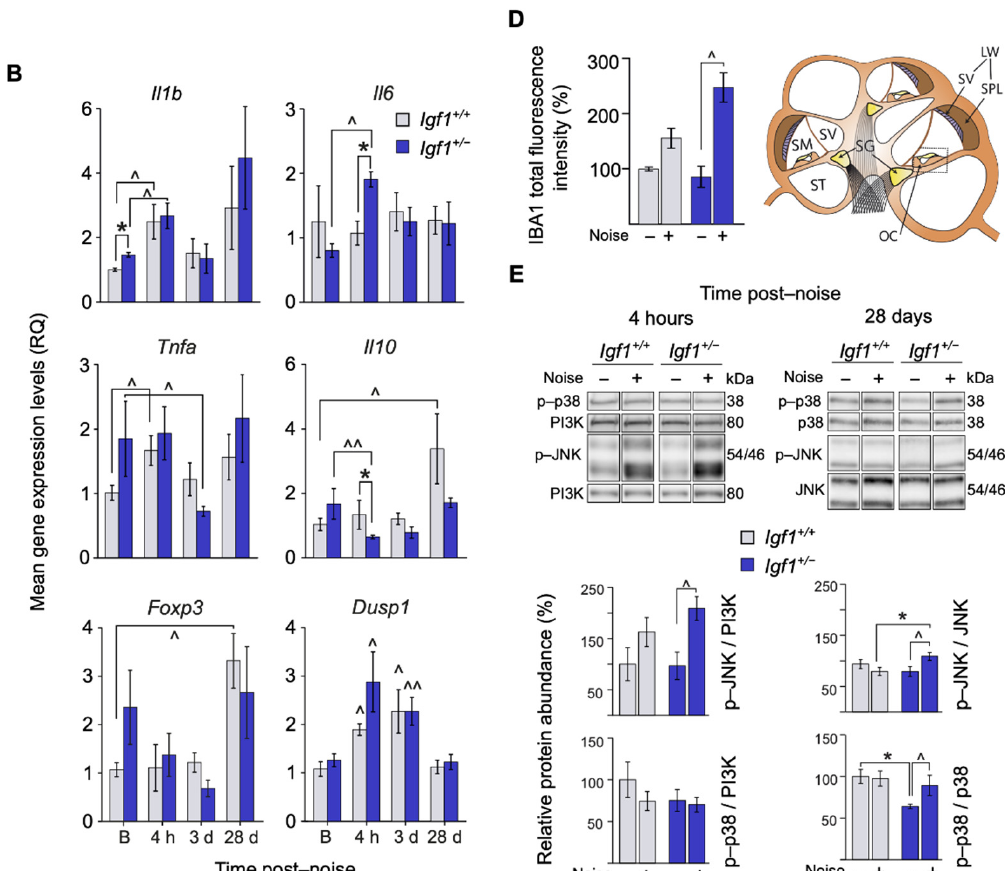
Figure 5. Noise effects on the activation levels of inflammation-related genes and proteins, infiltration of immune cells, and apoptosis-related genes in the cochlea of Igf1 +/ − mice. ( A , B ) Cochlear mRNA expression levels of ( A ) Tgf β 1 , Tgf β 2 , Tgf β r1 , and Tgf β r2 and ( B ) Il1 β , Il6, Tnf α , Il10, Foxp3, and Dusp1 were analyzed by RT-qPCR in WT and Igf1 +/ − mice before ( B ) and 4 h and 3 and 28 days after noise exposure. Gene expression levels were calculated as 2 − ∆∆ Ct (RQ) normalized with respect to the baseline WT mice group. Values are presented as mean ± SEM of at least 3 mice per condition evaluated in triplicate. Statistically significant differences were evaluated by the Mann–Whitney U test (* p < 0.05 between genotypes; ˆ p < 0.05; ˆˆ p < 0.01 vs. baseline group). ( C ) Representative microphotographs of cochlear mid-modiolar cryosections immunolabeled for IBA1 (red) showing ( a – g ) the spiral ligament of the cochlea in noise-exposed and non-exposed WT and Igf1 +/ − mice 3 days after noise exposure. Close-ups of the region of type IV fibrocytes in the spiral ligament are shown in ( c , g ). TUNEL positive cells were also found in this area (arrowheads in d and h ). Scale bars: ( a , b , e , f ) 100 µ m, ( c , g ) 50 µ m, and ( d , h ) 10 µ m. ( D ) IBA1 total fluorescence intensity was measured in the spiral ligament using ImageJ software. Data were obtained from 14 to 23 sections of at least 3 mice from each condition and are shown relative to those of non-exposed WT mice as mean ± SEM. Statistically significant differences were evaluated by the Mann–Whitney U test (ˆ p < 0.05 vs. baseline group). Schematic drawing showing the cross section of the cochlea. SM: scala media, ST, scala timpani, SV scala vestibuli, SG: spiral ganglion, OC: organ of Corti, LW: lateral wall, SV: stria vascular, SPL: spiral ligament. ( E ) Cochlear protein relative levels were measured by Western blotting. Representative blots and quantification of levels are shown for p-p38 and p-JNK cochlear protein extracts 4 h and 28 days post-noise exposure in noise-exposed and non-exposed WT and Igf1 +/ − mice. Expression levels were calculated as a ratio using PI3K or the non-phosphorylated forms of p38 and JNK and normalized to non-exposed WT mice groups. Values are presented as mean ± SEM of at least 3 mice per condition. Statistically significant differences were evaluated by the Mann–Whitney U test (* p < 0.05 between genotypes; ˆ p < 0.05 vs. baseline